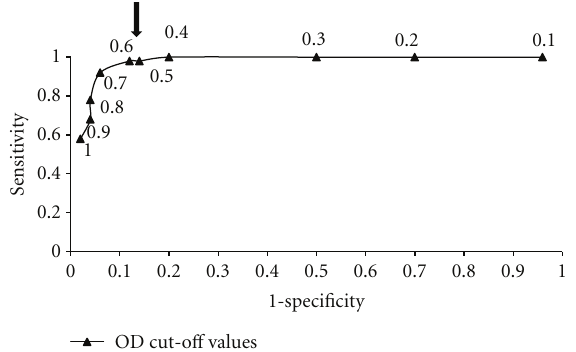
Figure 3: Receiver-operating characteristic curve for sensitivity and specificity (1-SP) in the enzyme-linked immunosorbent assays using ESEA antigens (AU isolate) at di ff erent arbitrary optical density (OD) cut-o ff values. Arrow: cuto ff